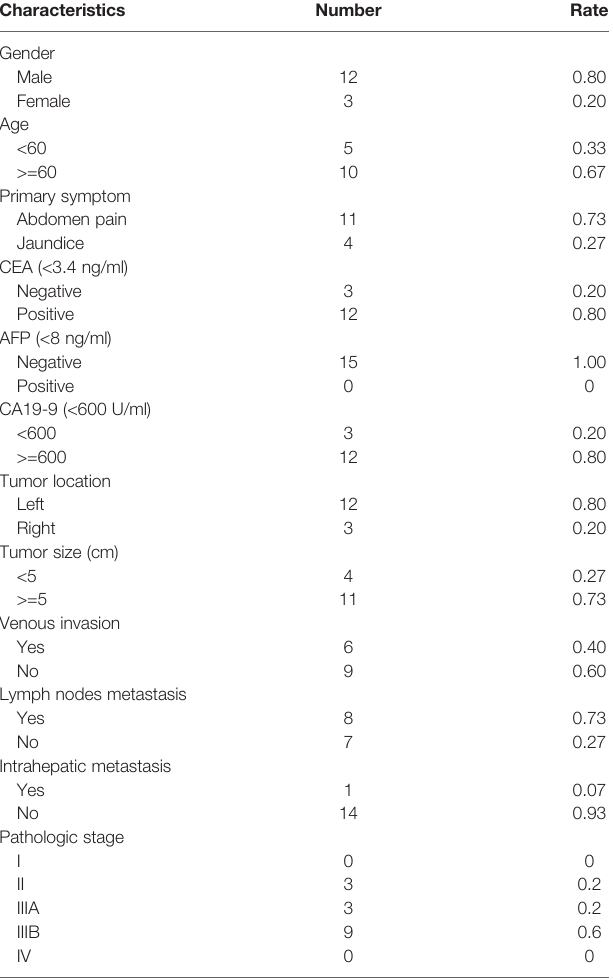
positive for diffuse or focal CK7 and CK19. p63, a member of the TABLE 2 | Clinicopathologic features of 15 cases.